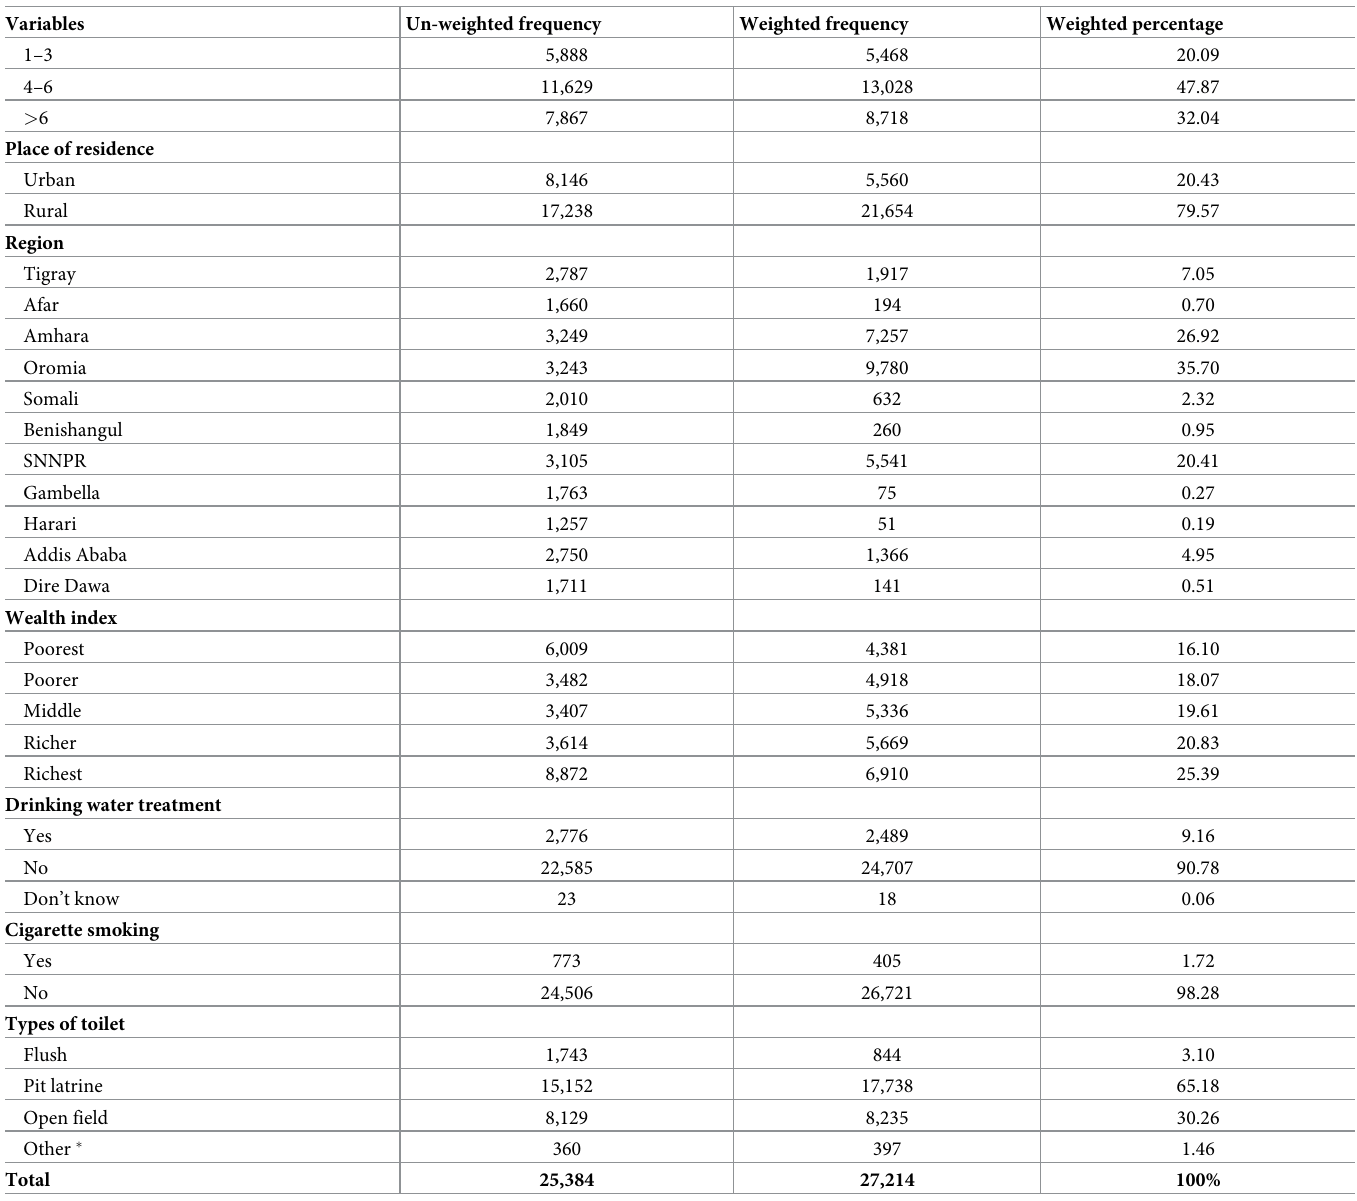
Spatial analysis of underweight Spatial distribution of underweight. The spatial distribution of underweight among individuals aged 15–49 years in Ethiopia was non-random (clustered) (Global Moran’s I = 0.79, p value < 0.0001) (Fig 1). The highest proportions of underweight was located in the Tigray, Amhara, western and central part of Afar and Gambella regions, while low